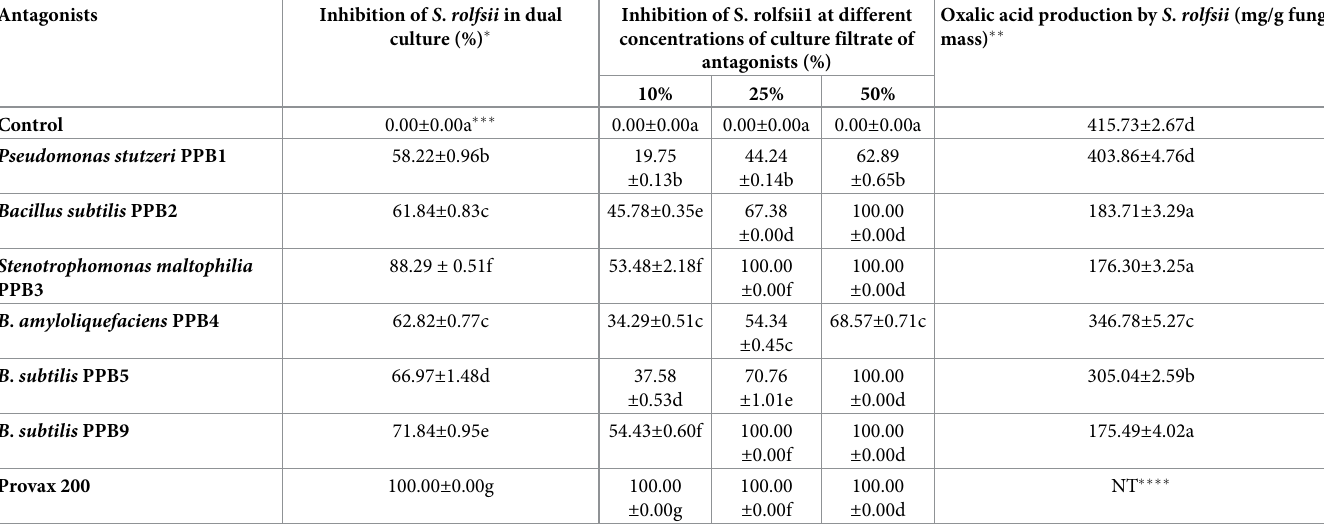
Table 1. Inhibition of mycelial growth and oxalic acid production of Sclerotium rolfsii by bacterial antagonists.